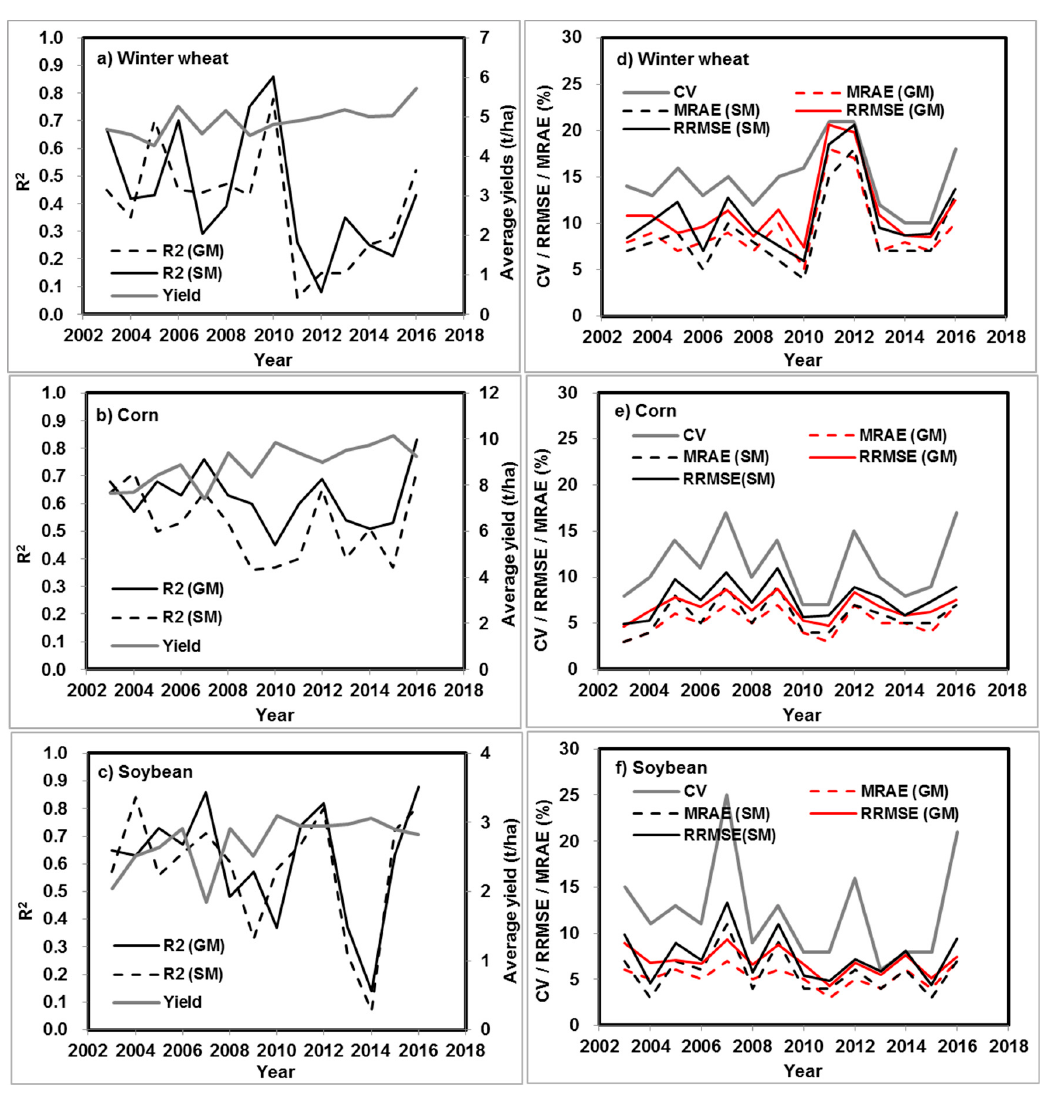
Figure 5. Annual variation of the strongest correlation between crop yields and time-series EVI2, extracted using a general cropland mask (GM) and crop-specific masks (SM) for winter wheat ( a , d ), corn ( b , e ), and soybean ( c , f ). Yield: average county level yield; R 2 : coe ffi cient of determiantion; CV: coe ffi cient of variation of yields; RRMSE: root mean square error relative to average yield; MRAE: mean relative absolute error. Samples from the three agricultural regions were analyzed For winter wheat (Figure 5a, d), county level annual yield variability—represented by CV—was between 10% and 21% during the 14 year period. Except for 2011 using the general cropland mask and 2012 using crop specific mask, the strongest linear correlation between yields and EVI2 was significant at the 5% level ( n = 27). The correlations between yields and EVI2 showed a strong inter-annual variation, as represented by both MRAE and